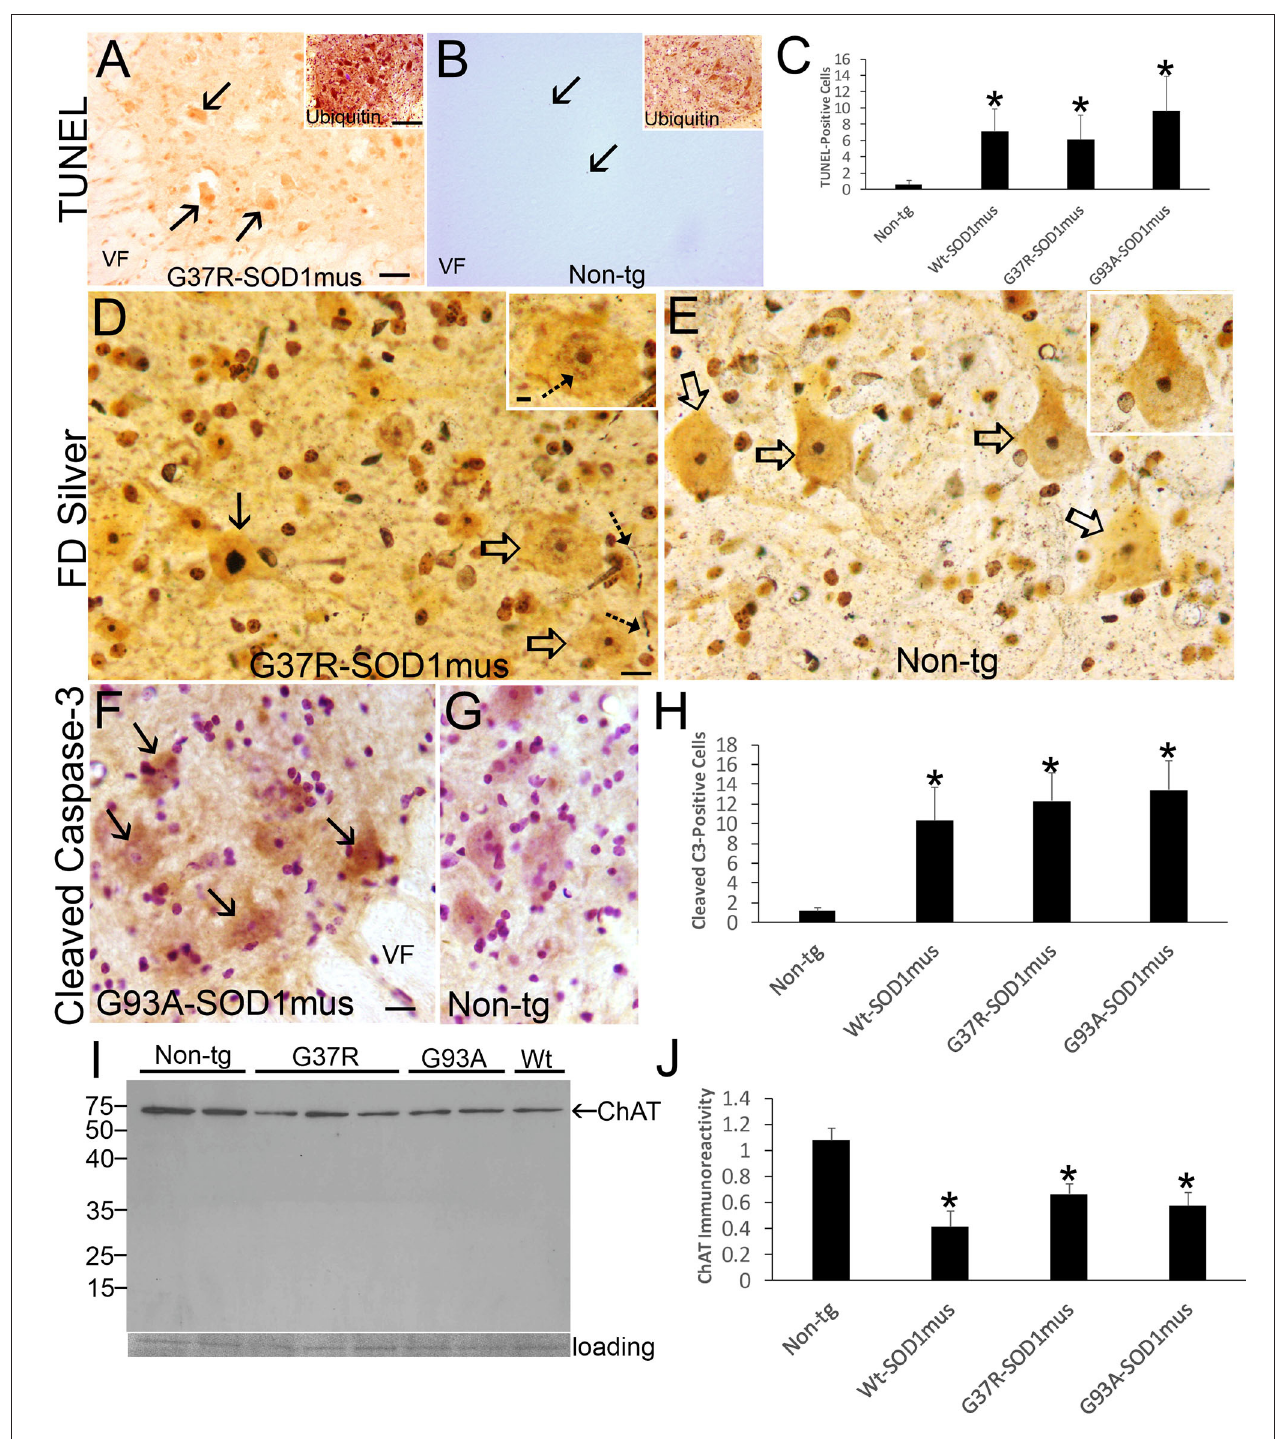
FIGURE 9 | Motor neuron cell death in hSOD1 mus mice is an apoptotic-like process. (A) TUNEL visualized DNA-DSB accumulation in nuclei of dying motor neurons (arrows) in G37R-hSOD1 mus mouse lumbar spinal cord. Inset shows strong accumulation of ubiquitin in motor neurons. VF, ventral funiculus. Scale bar = 45 µ m (same for B); A inset scale bar = 42 µ m [same for (B) inset]. (B) Motor neurons in age-matched control mouse lumbar spinal cord were TUNEL-negative. A few TUNEL-positive small cell nuclei were detected (arrows). Inset shows ubiquitin immunoreactivity is less apparent compared to G37R-hSOD1 mus mouse [ (A) , inset].